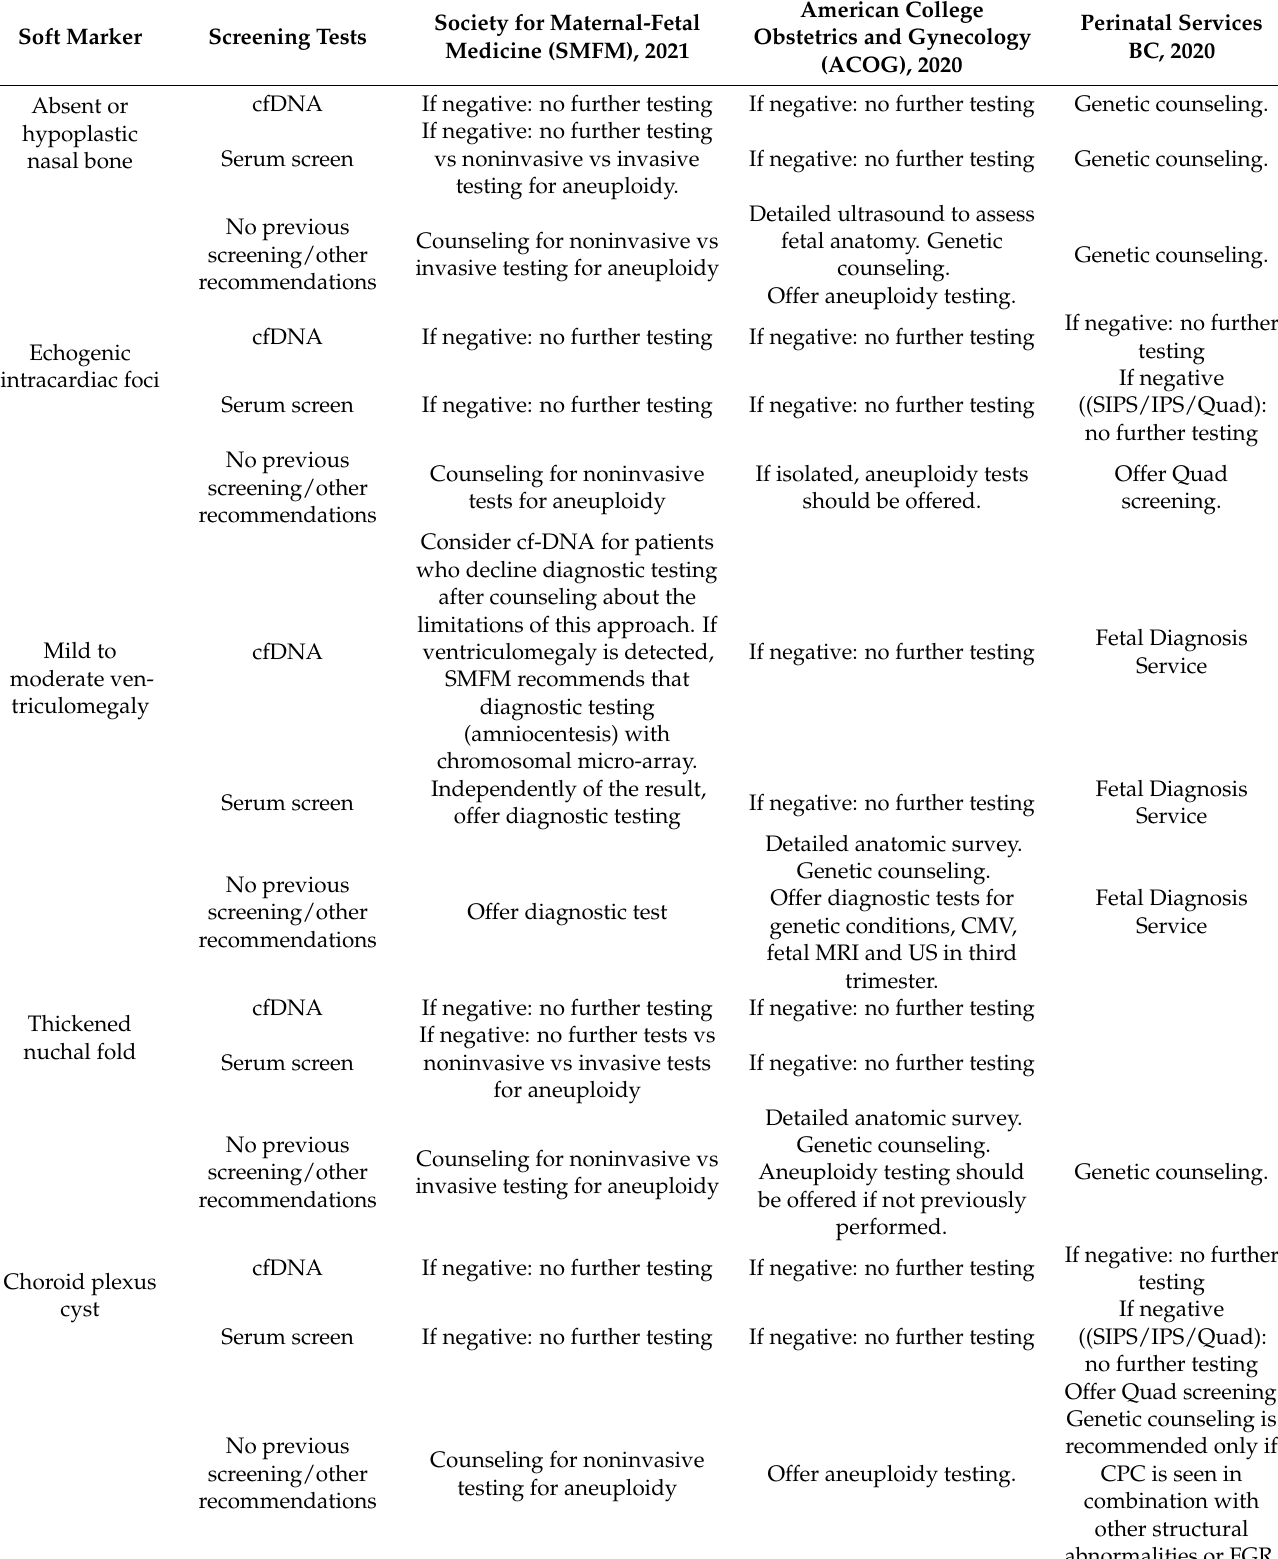
Table 1. Management of isolated second trimester sonographic soft